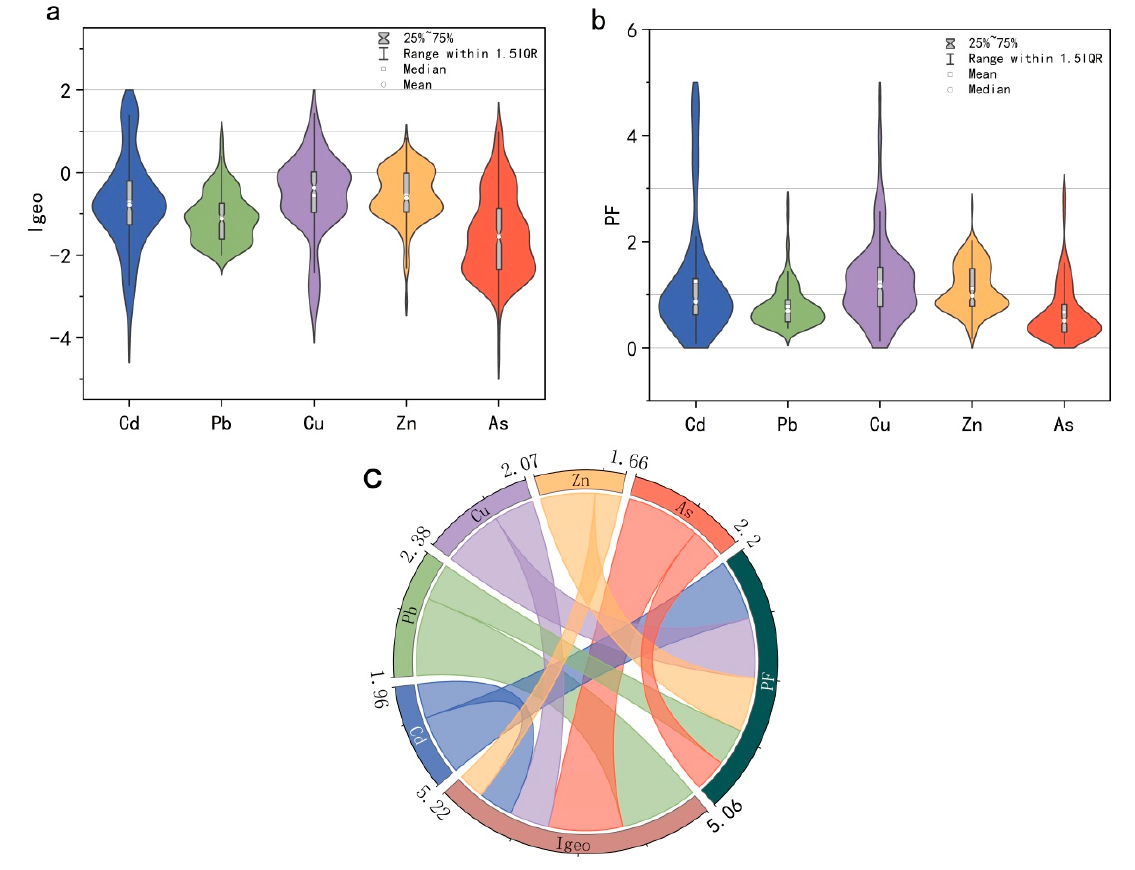
Figure 4. Violin with box plot of soil PTEs in the study area ( a ) I geo , ( b ) PF, and ( c ) the relationship between soil PTEs and environmental indices.